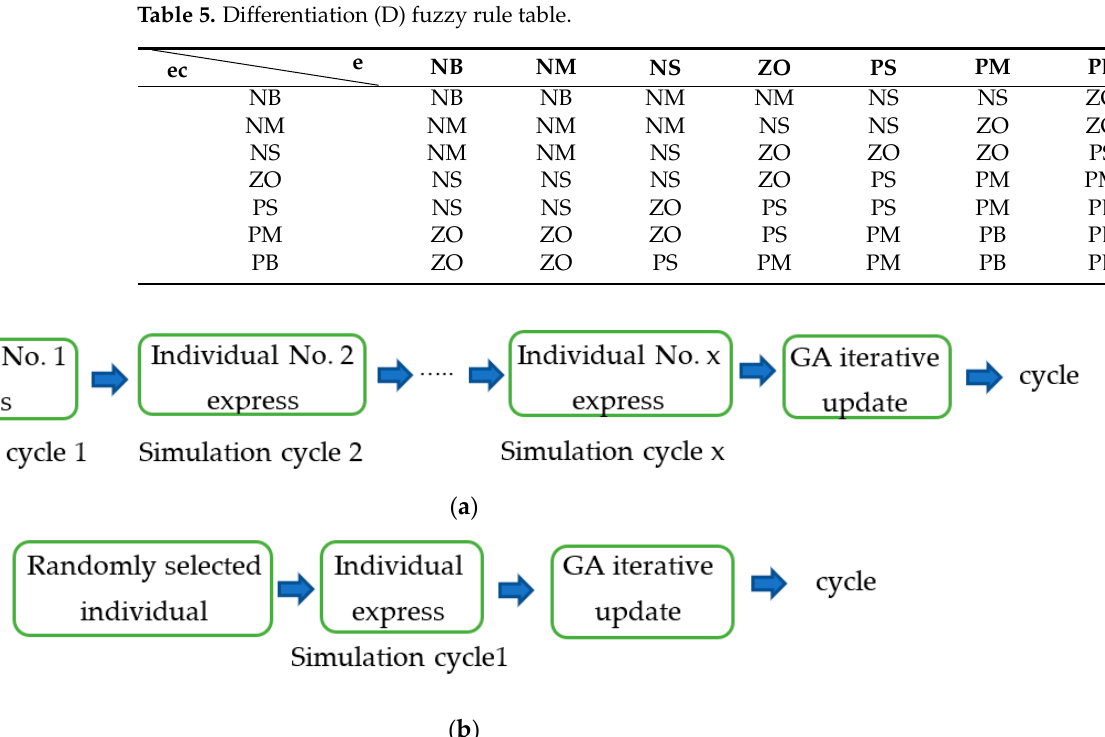
Figure 6. ( a ) Algorithm iteration scheme I; ( b ) Algorithm iteration scheme II.